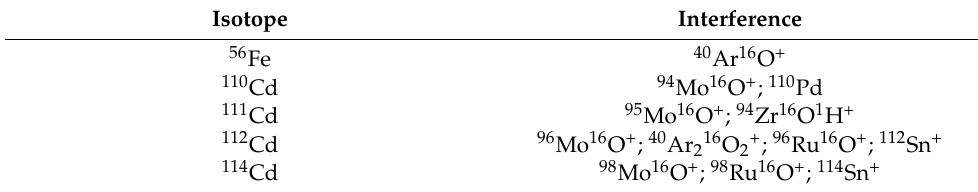
Table 3. Potential polyatomic interferences on Fe and Cd isotopes.